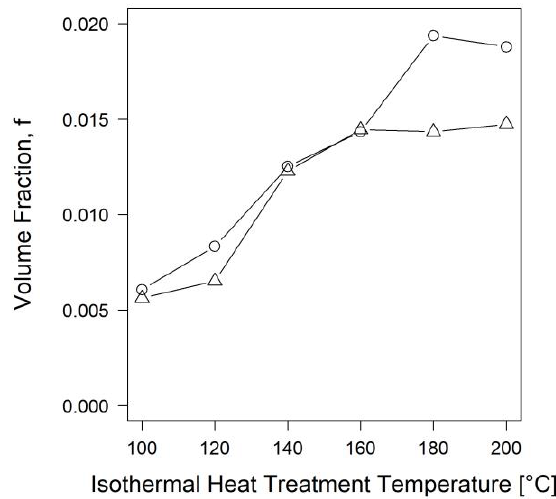
Figure 7. Average precipitate diameters as a function of isothermal anneal temperature for ( a ) Al-Zn-Mg alloy and ( b ) Al-Zn-Mg-Cu alloy; open points are SAXS precipitate measurements and solid points are TEM precipitate measurements; error bars show one standard deviation of the mean.